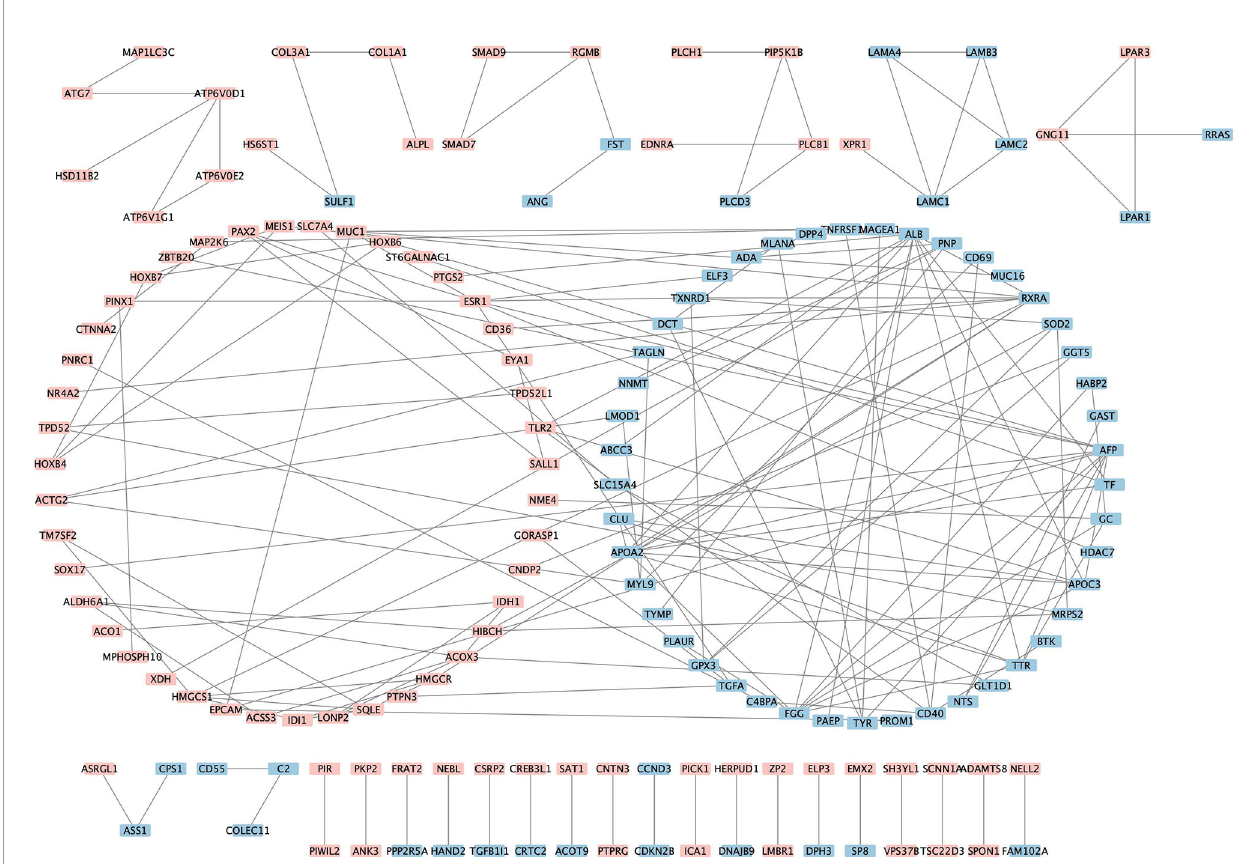
FIGURE 4 | Visualization of the protein-protein interaction network. Pink denotes the up-regulated genes while blue denotes the down-regulated genes.